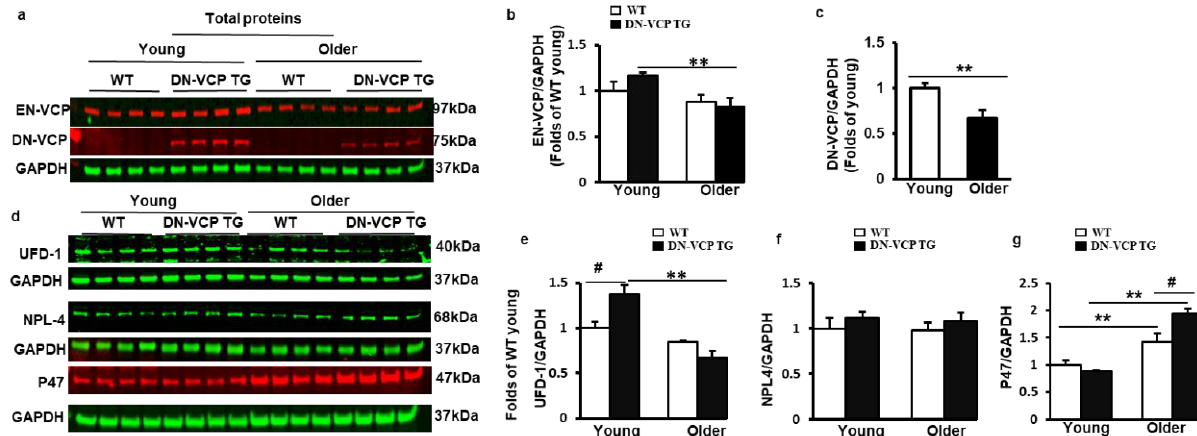
Figure 3. DN-VCP aggravates the age-related alterations in EN-VCP and its co-factors in TG mouse hearts. ( a ). The representative images of Western blots reflect the total protein levels of endogenous VCP (EN-VCP) and dominant-negative VCP (DN-VCP) in DN-VCP TG mice compared to their age-matched WT mice at both young and older ages. GAPDH was used as a loading control; ( b , c ). The quantitated values of the total proteins of EN-VCP ( b ) and DN-VCP ( c ) normalized to the GAPDH in the hearts; (d). The representative Western blots reflect the total protein levels of VCP’s co-factors in DN-VCP TG mice compared to their age-matched WT mice. GAPDH was used as a loading control of the total proteins; ( e – g ). The relative total protein value of the VCP-cofactors, ubiquitin fusion degradation protein 1 (UFD-1) ( e ), nuclear protein localization protein 4 (NPL-4) ( f ), and P47 ( g ), in TG and WT mice. N = 4/group. **, p ≤ 0.01 vs. corresponding young mice. #, p ≤ 0.05, vs. age-matched WT mice.